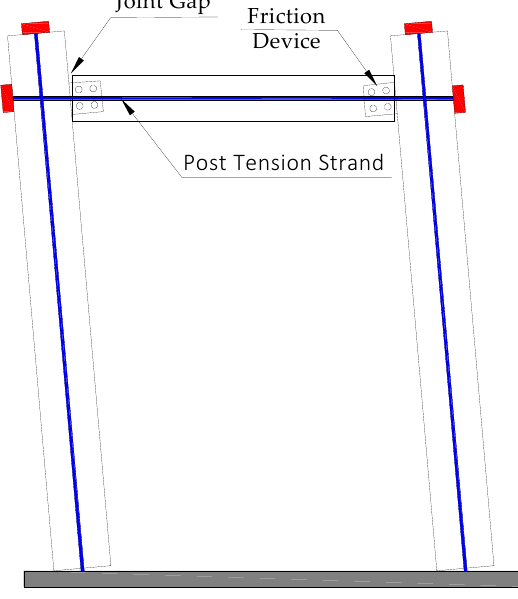
Figure 24. Frame drift [47].